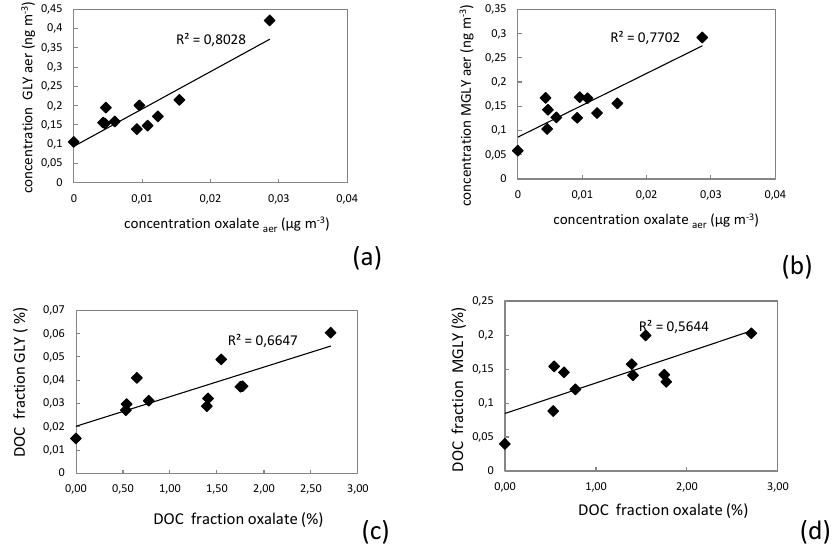
Fig. 5. Correlation of GLY/MGLY and oxalate: (a) and (b) concentration, (c) and (d) DOC fraction. ∗ DOC fraction was calculated from GLY, MGLY and oxalate concentrations and their contribution to DOC concentrations on a carbon basis.